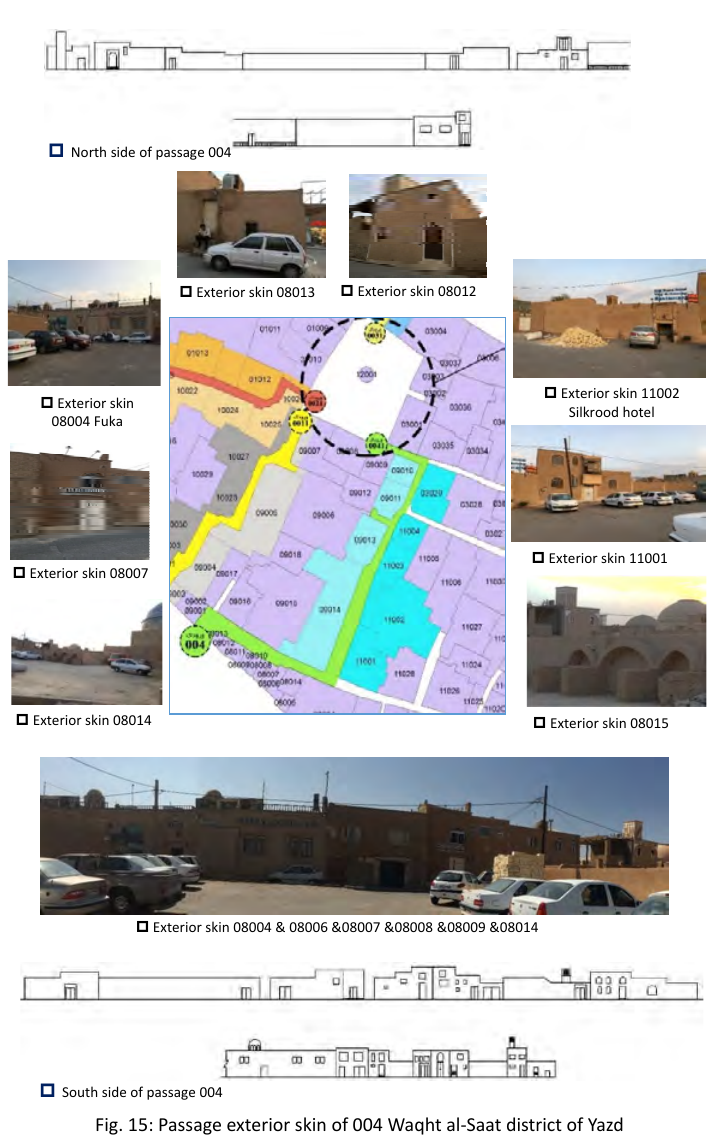
Fig. 15: Passage exterior skin of 004 Waqht al-Saat district of Yazd